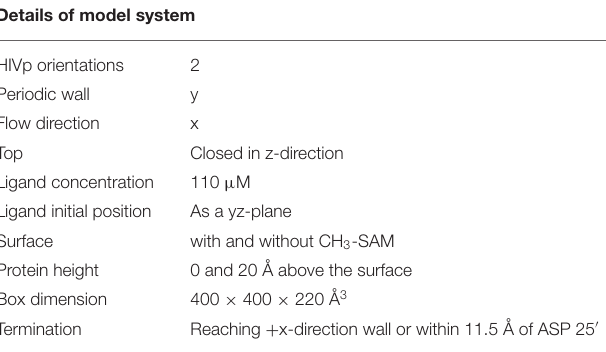
TABLE 1 | Summary of molecular systems used in this